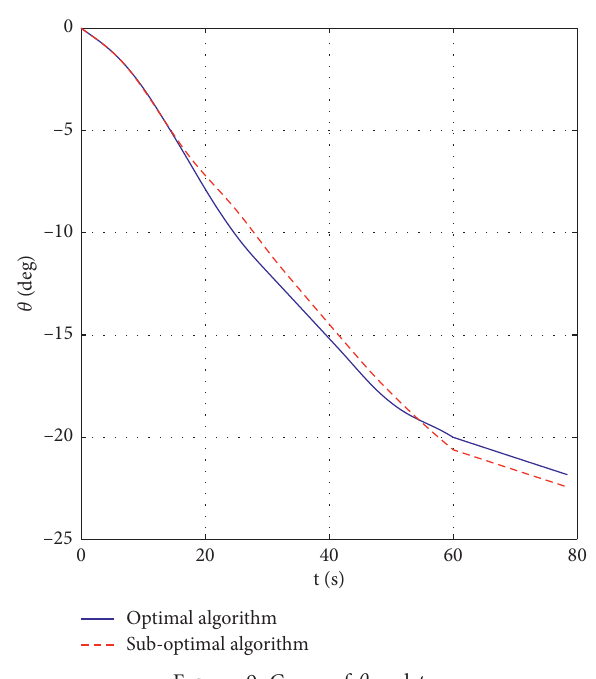
Figure 9: Curve of θ and t